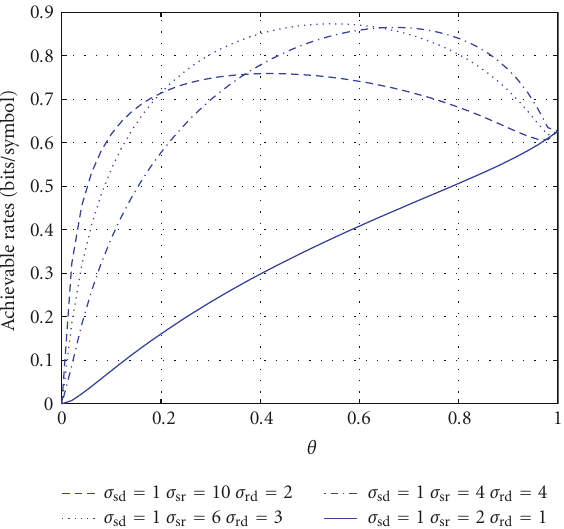
Figure 14: Overlapped AF achievable rate versus θ . P = 1, and m =